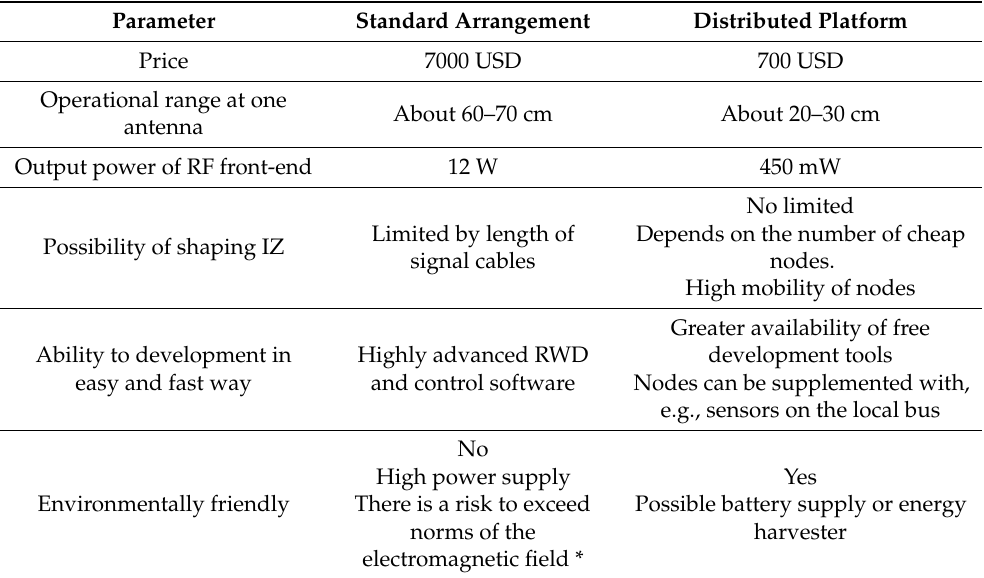
Table 1. Comparison of RFID systems.